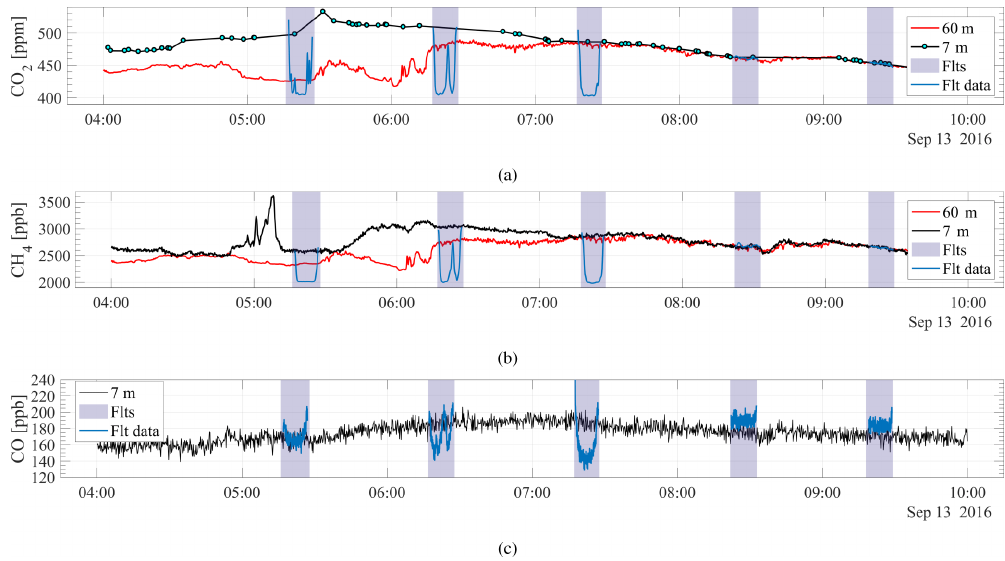
Figure 8. The continuous CO 2 (a) , CH 4 (b) , and CO (c) measurements from the atmospheric tower at 7m (black) and 60m (red), along with the mole fractions measured with the active AirCore (blue). The highlighted areas indicate the time span for each of the flights, approximately spaced 1h apart. The altitude covered during the flights was 485, 301, 478, and 23m for flight nos. 1, 2, 3, and 4, respectively, transecting